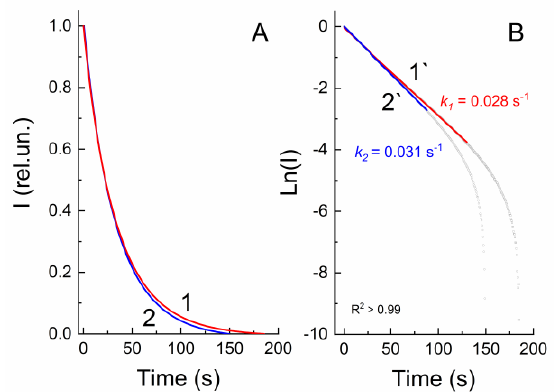
Figure 4. Normalized kinetic curves ( A ) of the transition process of the merocyanine form of 22 to the spiropyran form measured at 605 nm without (1) (dark bleaching) and upon irradiation (2) through a SZS − 9 light filter (photobleaching). Linear anamorphoses ( B ) of kinetic curves 1 and 2 in the Ln(I) – time(s) coordinates.